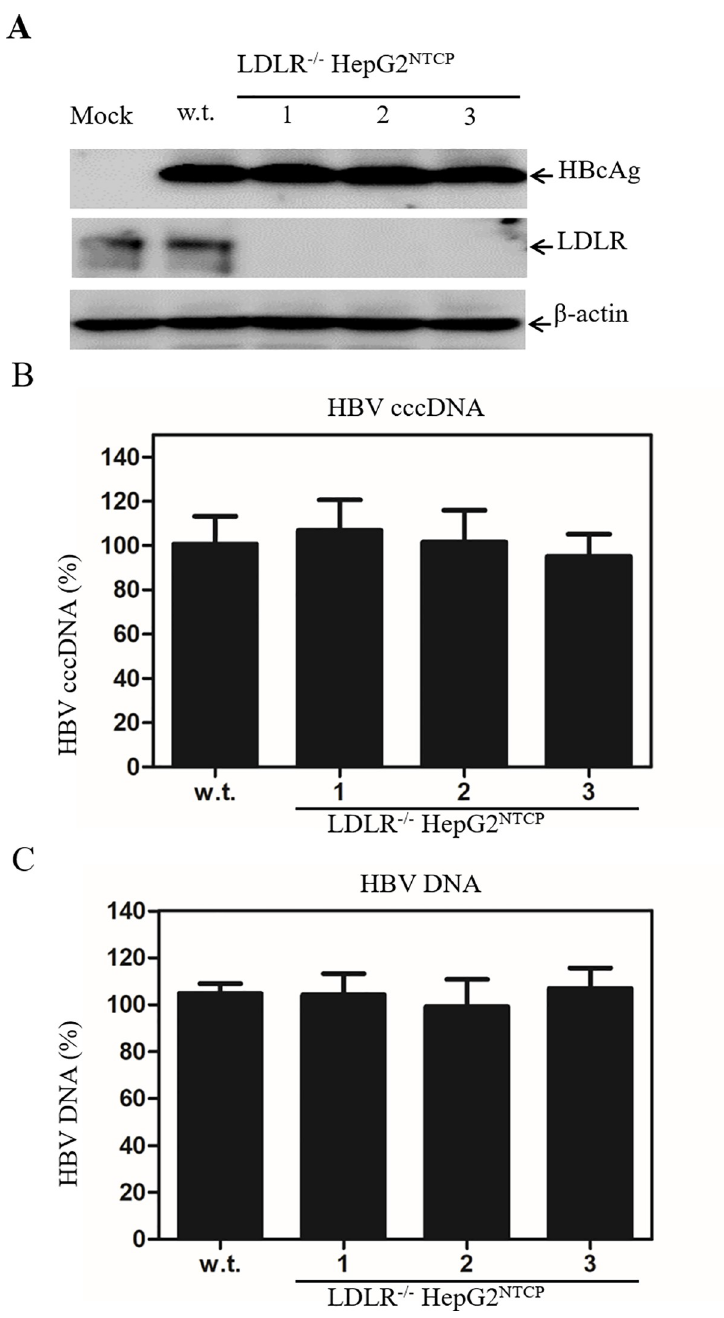
Fig 7. Effects of LDLR gene knockout on HBV DNA replication. The LDLR -/- HepG2 NTCP cell lines in 24-well plates were transfected with 1 μ g of infectious HBV DNA plasmid (pCMV-HBV) that was previously described [59]. At 48 h p.t., cell lysates were collected and DNA was extracted with a QIAGEN DNA isolation kit. The levels of HBcAg ( A ) were determined by Western blot. HBV cccDNA was isolated using the Hirt method and total HBV DNA was extracted with a QIAGEN DNA isolation kit. Possible HBV plasmid DNA was removed by treating DNAs with the restriction enzyme DpnI. HBV rcDNA was digested by treatment of DNA sample with exonuclease I, III, and T5. The levels of HBV cccDNA ( B ) and DNA ( C ) were determined by qPCR methods. The levels of HBV cccDNA and DNA are shown as percentage (%) of control considering 100% of HBV cccDNA and DNA in the parental HepG2 NTCP cells (w.t.).